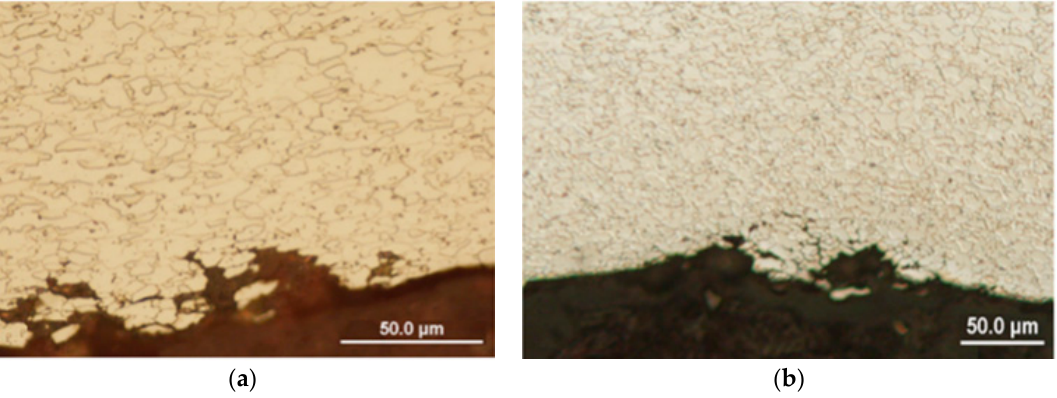
Figure 10. Deformed material structure after uniaxial tensile test: ( a ) rolling direction 0°; ( b ) rolling direction 90°.